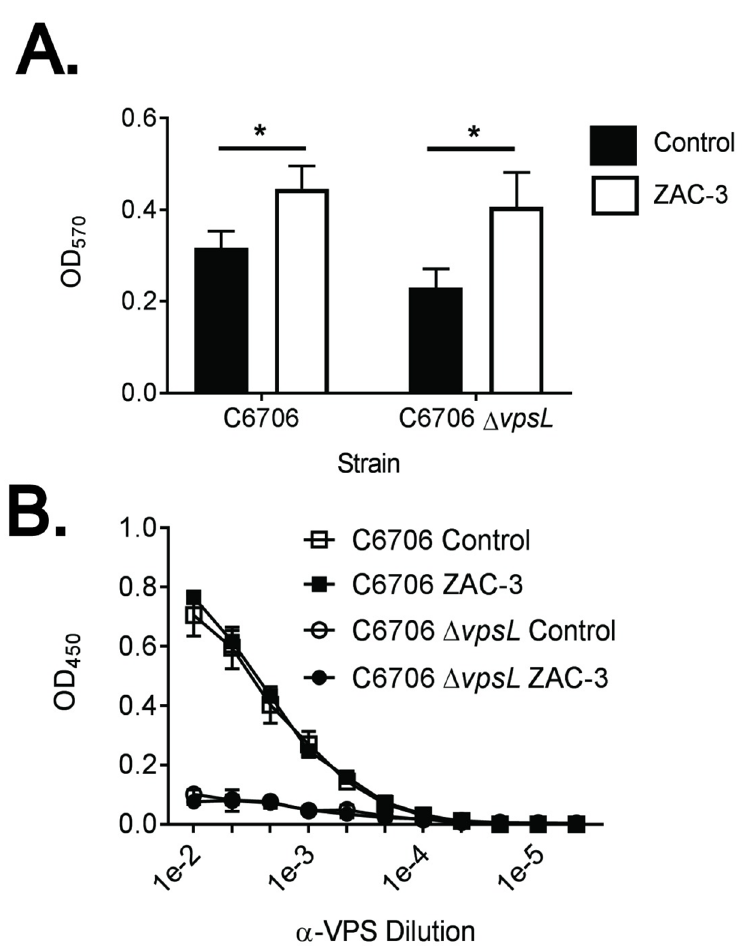
Fig 7. ECM production by V . cholerae C6706 in response to ZAC-3 IgG is VPS independent. Mid-log phase cultures of either V . cholerae C6706 El Tor or an isogenic vpsL mutant were treated for 1 h at 37˚C in static conditions with ZAC-3 (9 μ g/mL) or an isotype control MAb. Both strains displayed, as compared to isotype controls, increased levels of CV straining in response to ZAC-3 IgG, as determined by a two-way ANOVA followed by a Tukey multiple comparison test. (cid:3) ; P < 0.05. The results presented are the average of at least three biological replicates with three technical replicates each. (B) ECM-ELISA of the same treatment groups described above, with no significant difference in VPS signal seen between the control and ZAC-3 treated groups in either strain, as determined by two-way ANOVA followed by a Tukey multiple comparison test. Graph is composed of data from two biological replicates with 2 technical replicates